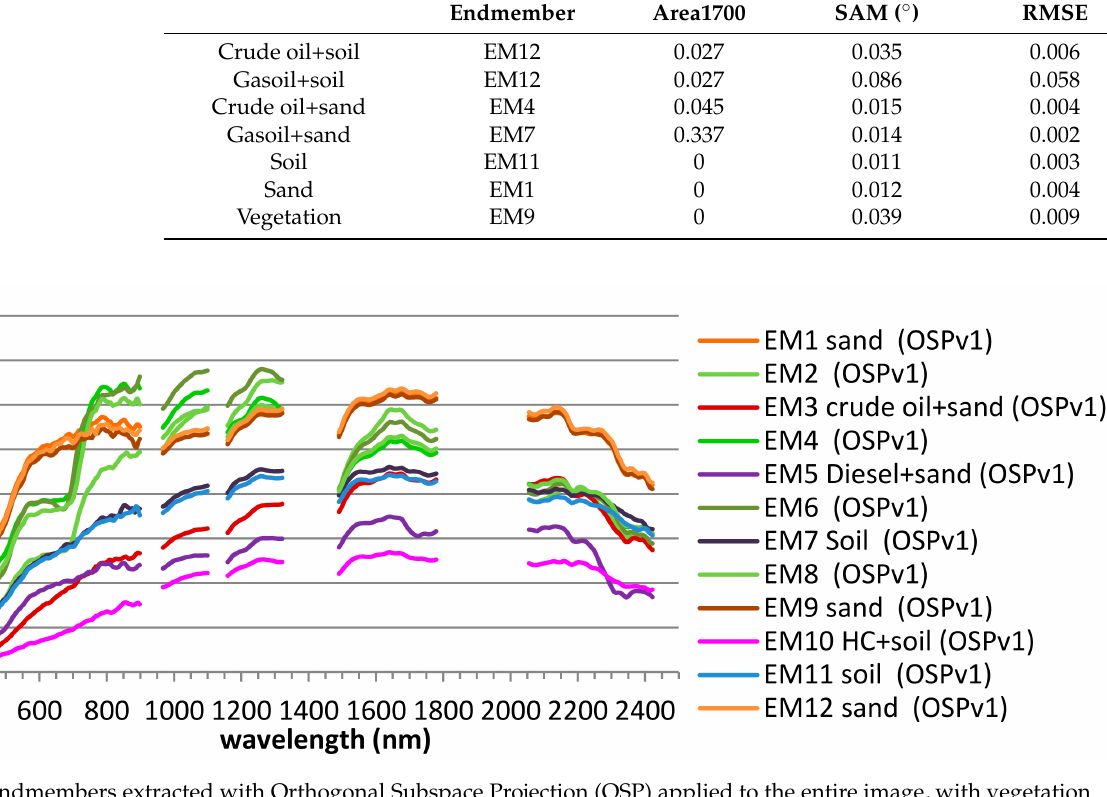
Figure 6. Endmembers extracted with Orthogonal Subspace Projection (OSP) applied to the entire image, with vegetation rejection test (Case